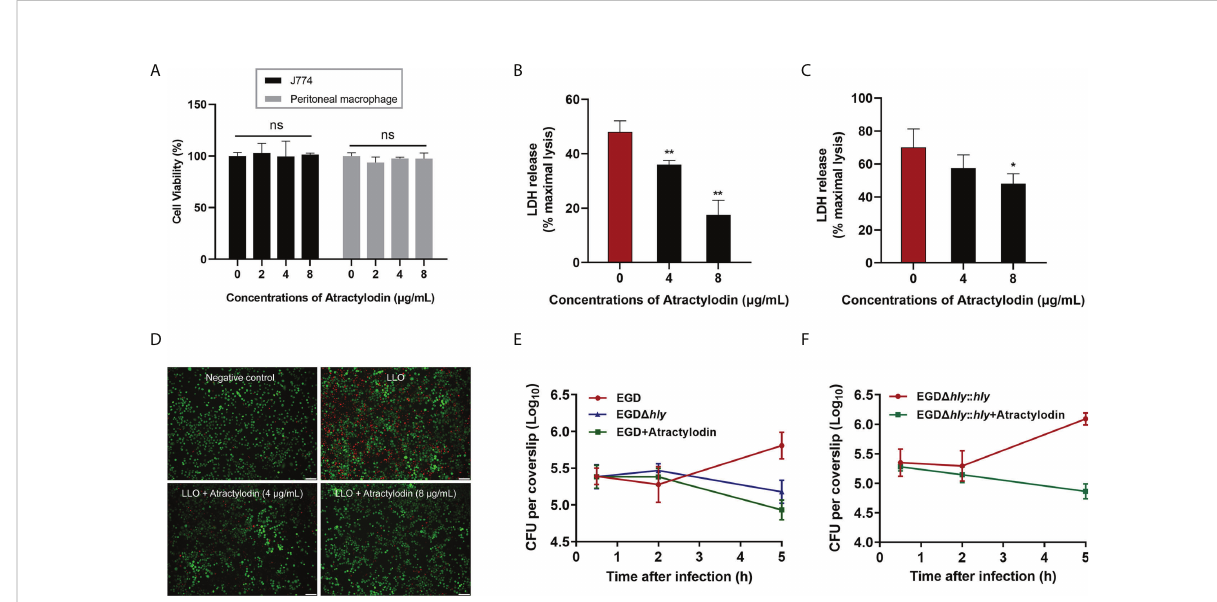
FIGURE 3 Atractylodin treatment ameliorated L. monocytogenes EGD ‐ induced cellular injury. (A) The cell toxicity determination of atractylodin on J774A.1 cells and peritoneal macrophages for 6 h using a CCK-8 kit. Cytotoxicity induced by LLO (B) and L. monocytogenes EGD (C) in J774A.1 cells with the presence and absence of atractylodin. (D) J774A.1 cells co-cultured with LLO in the presence of indicated concentrations of atractylodin were stained with the Live/Dead (green/red) reagent. Live cells were stained in green, and dead cells were stained in red. Scale bar, 50 m m. (E) Cells were infected with EGD in the presence or absence of atractylodin (4 m g/mL) or the hly deletion mutant EGD D hly . At 0.5, 2 and 5 h post-infection, cells were lysed and the total colony-forming units (CFUs) of intracellular bacteria were monitored by microbiology counting. (F) Intracellular growth curve of complementation strain EGD D hly :: hly after co-incubated with or without atractylodin (4 m g/mL) were performed as described above. All of the data are representative of three independent experiments and presented as the mean ± SEM. ns, P > 0.05, * P < 0.05, ** P <